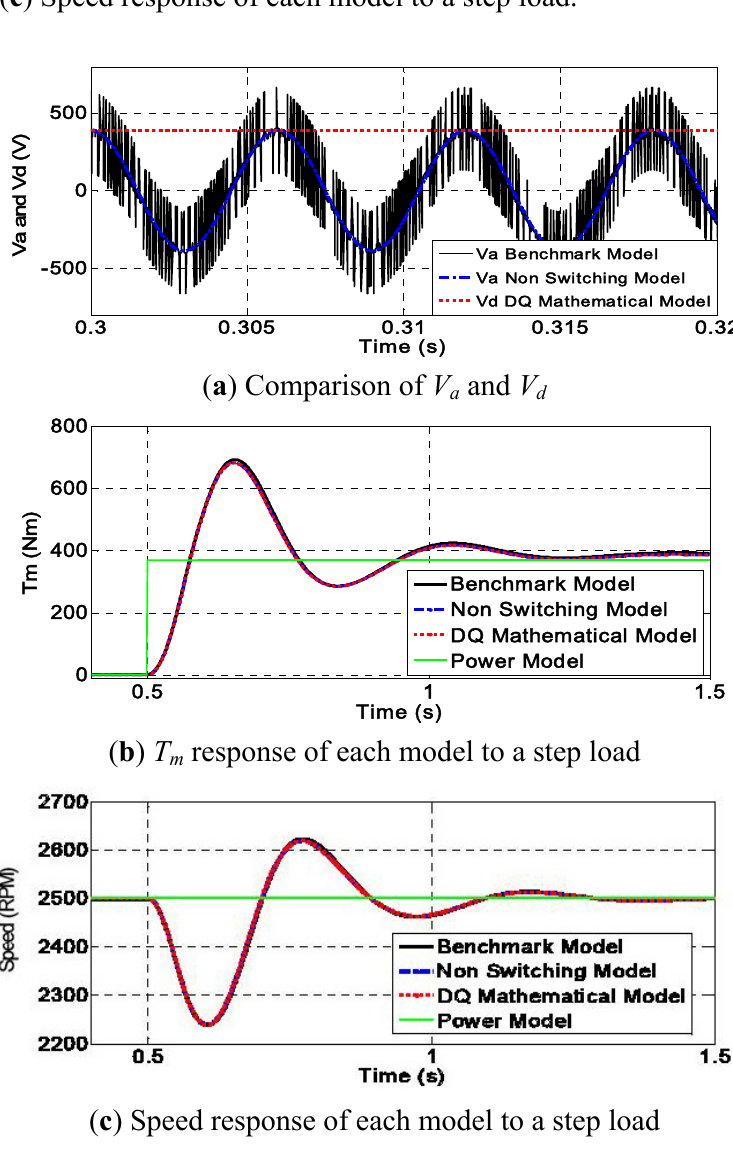
and V ; ( b ) Tm response of each model a d